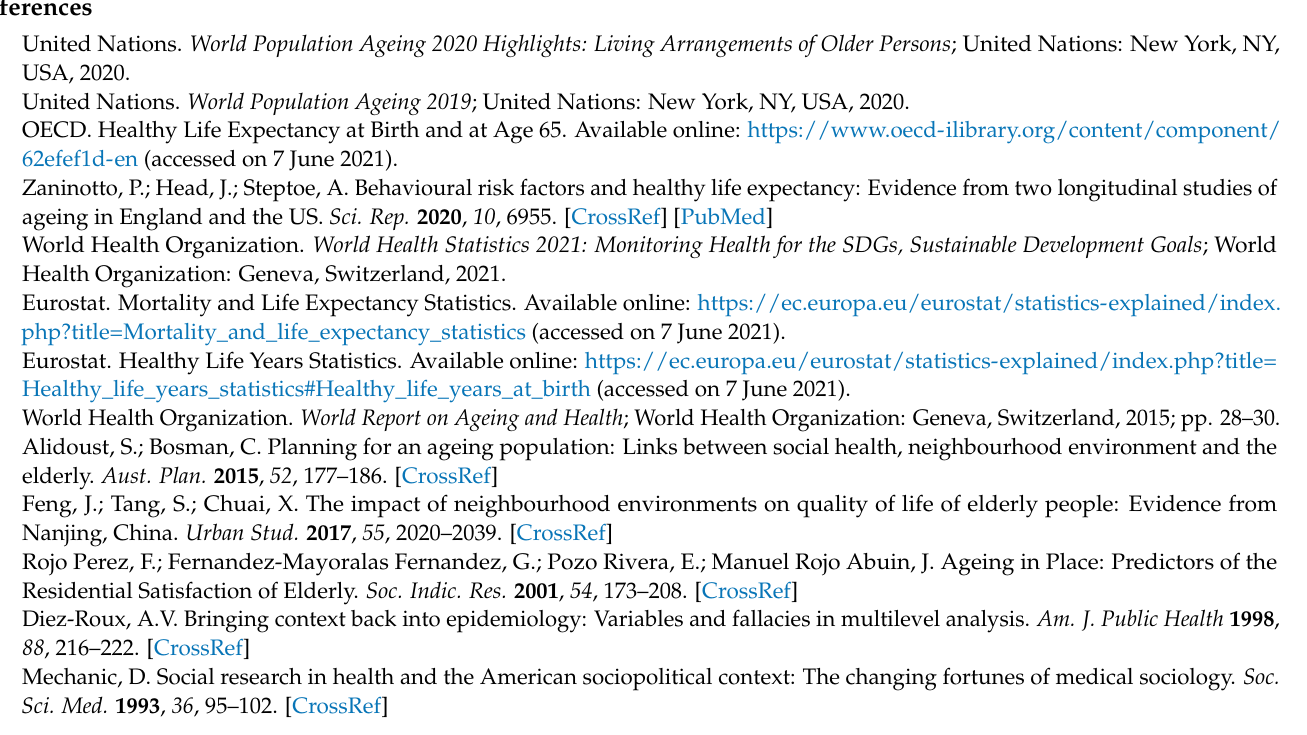
Table S2: Terms used in the search expression of Scopus, Web of Science and Pubmed; Table S3: Characteristics of the included studies ( n = 122); Table S4: Categorisation of the outcomes studied into the domain(s) of healthy ageing; Table S5: Indicators used to measure neighbourhood socioeconomic